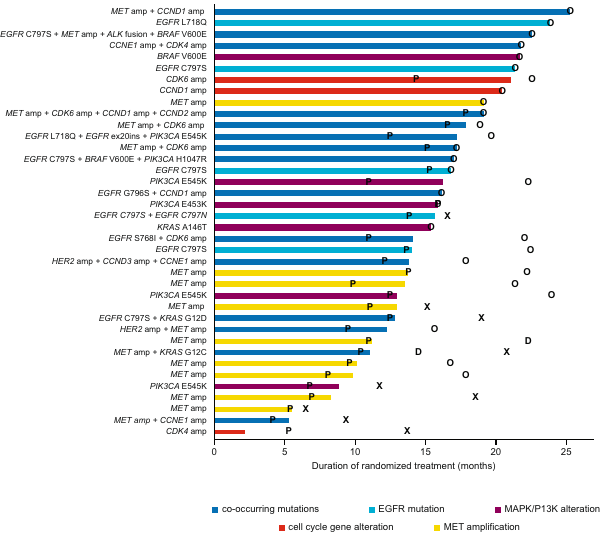
Fig. 3 | Comparator EGFR-TKI duration of treatment by candidate resistance mechanisms. Swimmer plot indicating duration of treatment with comparator EGFR-TKI(months)byresistancemechanisms( n =145).Sourcedataareprovidedin the Supplementary Data 1 fi le. EGFR epidermal growth factor receptor, X time of deathforpatientswhohavedied,Odatelastknownaliveforpatientswhohavenot died, P time of progression, as assessed by investigator, D time of study